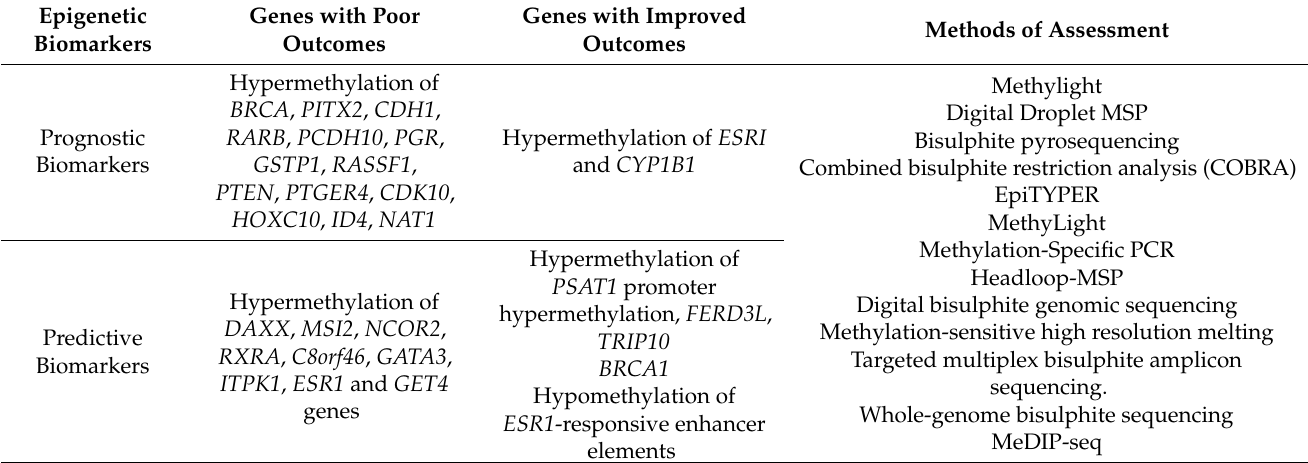
Table 3. DNA Methylation Biomarkers in Breast